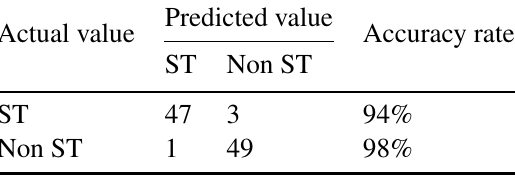
Table 5 Prediction results of random effect